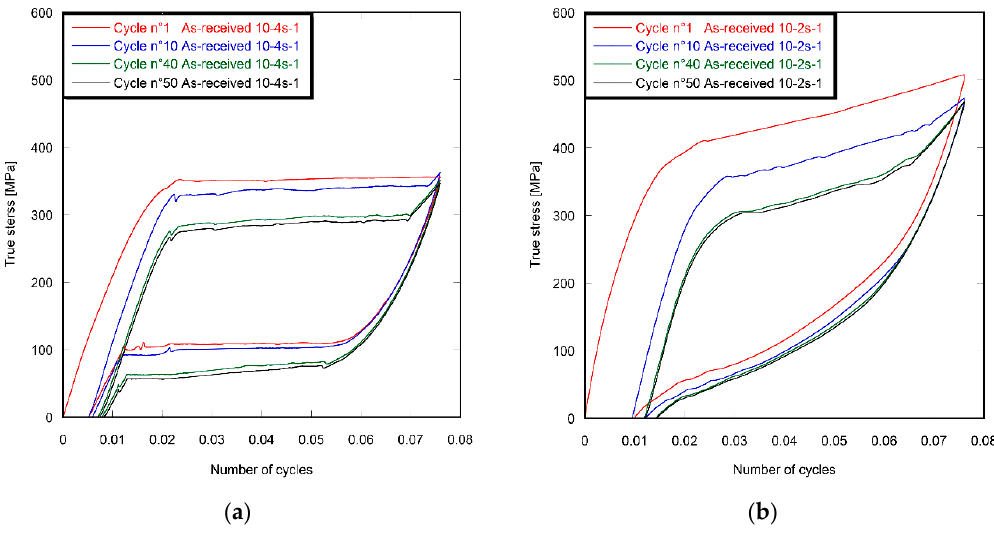
Figure 3. Tensile stress-strain curves with imposed strain rate of 10 − 4 s − 1 of ( a ) as-received and ( b ) hydrogen charged for 6 h and aged superelastic NiTi Shape Memory Alloy.